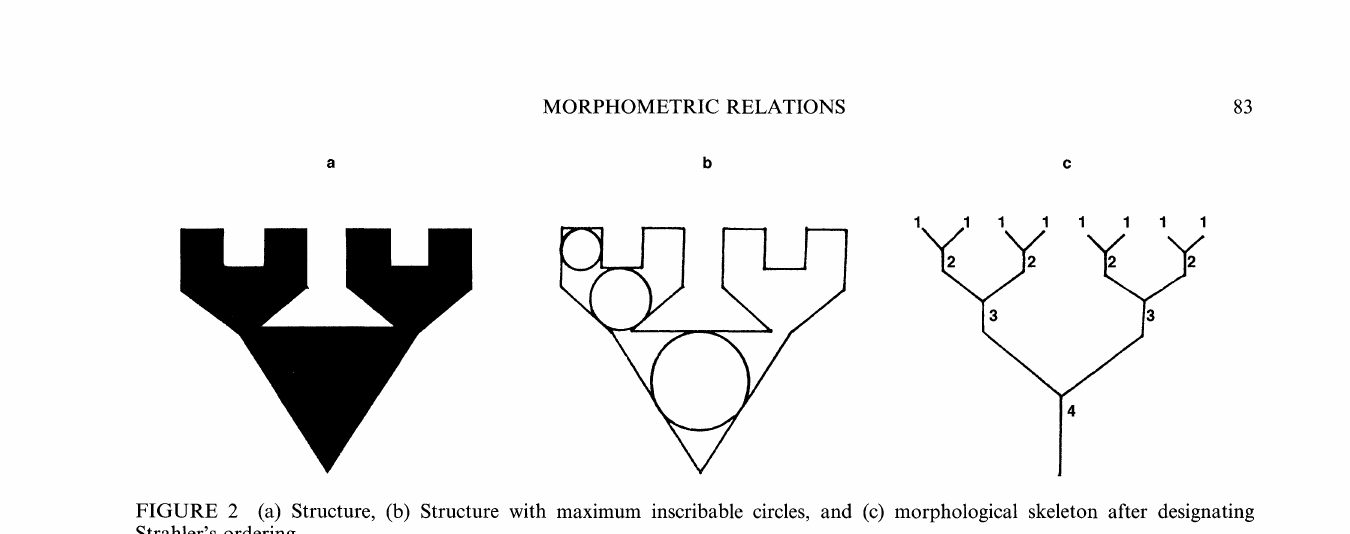
FIGURE 2 (a) Structure, (b) Structure with maximum inscribable circles, and (c) morphological skeleton after designating Strahler’s